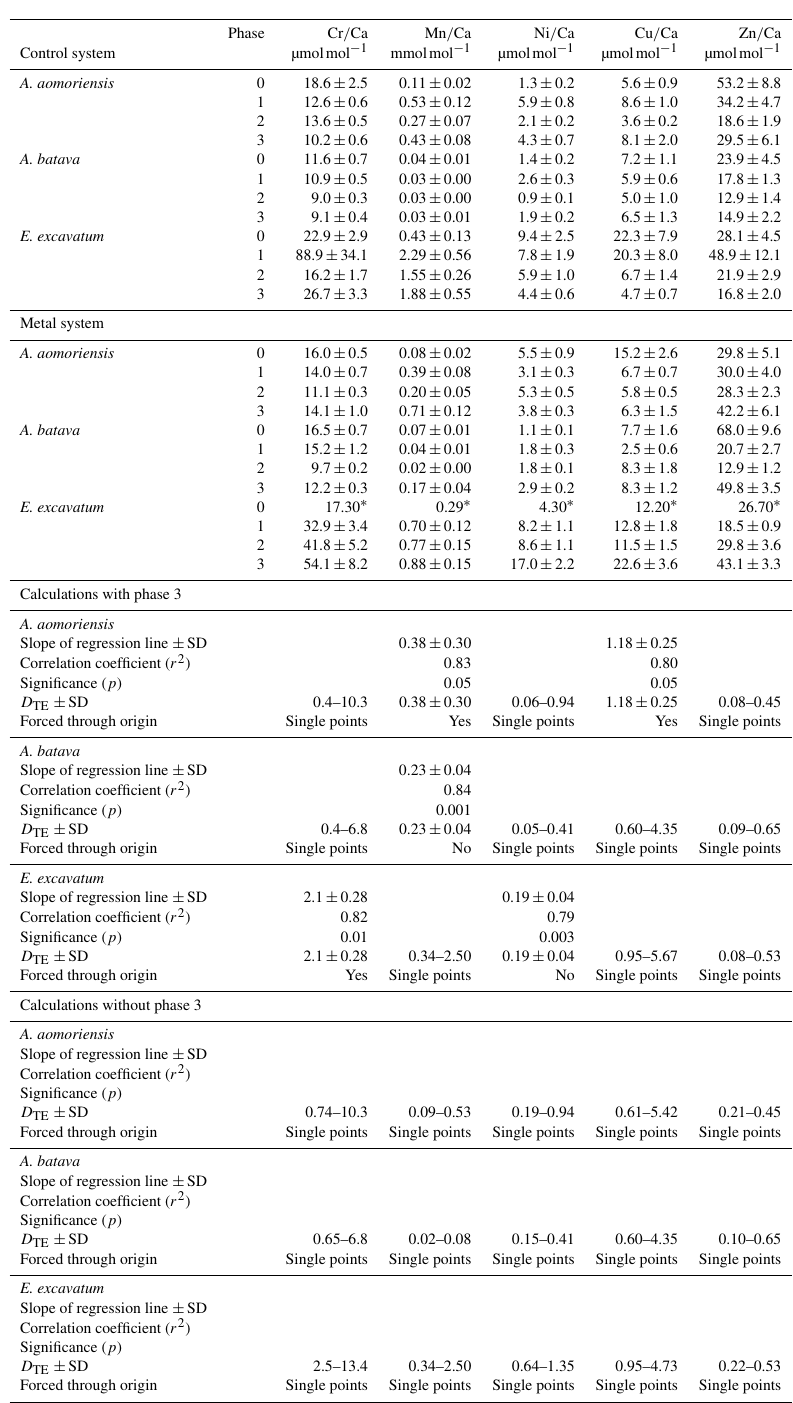
Table 4. Mean heavy-metal-to-calcium values of A. aomoriensis , A. batava and E. excavatum in the control and the metal system. Errors √ n ). Values marked with an asterisk were derived from only one laser spot and thus are standard errors of the mean (standard deviation σ/ are not considered for further discussion. Furthermore, the calculated D TE values, the slope of the linear regression line (OLS – ordinary least squares) of all means, Pearson’s correlation coefficient ( r 2 ) and its significance ( p ) are given for the calculation with all phases and when removing phase 3 from the calculations. Cases where the regression lines were forced through the origin are indicated. In cases when a regression did not show significant correlation, the D TE range calculated separately from the individual phases is given. In cases when the regression was significant, the D TE values represent the slope of the regression line. Ph is phase; SD is standard deviation. Values in Table S1 are the basis of all